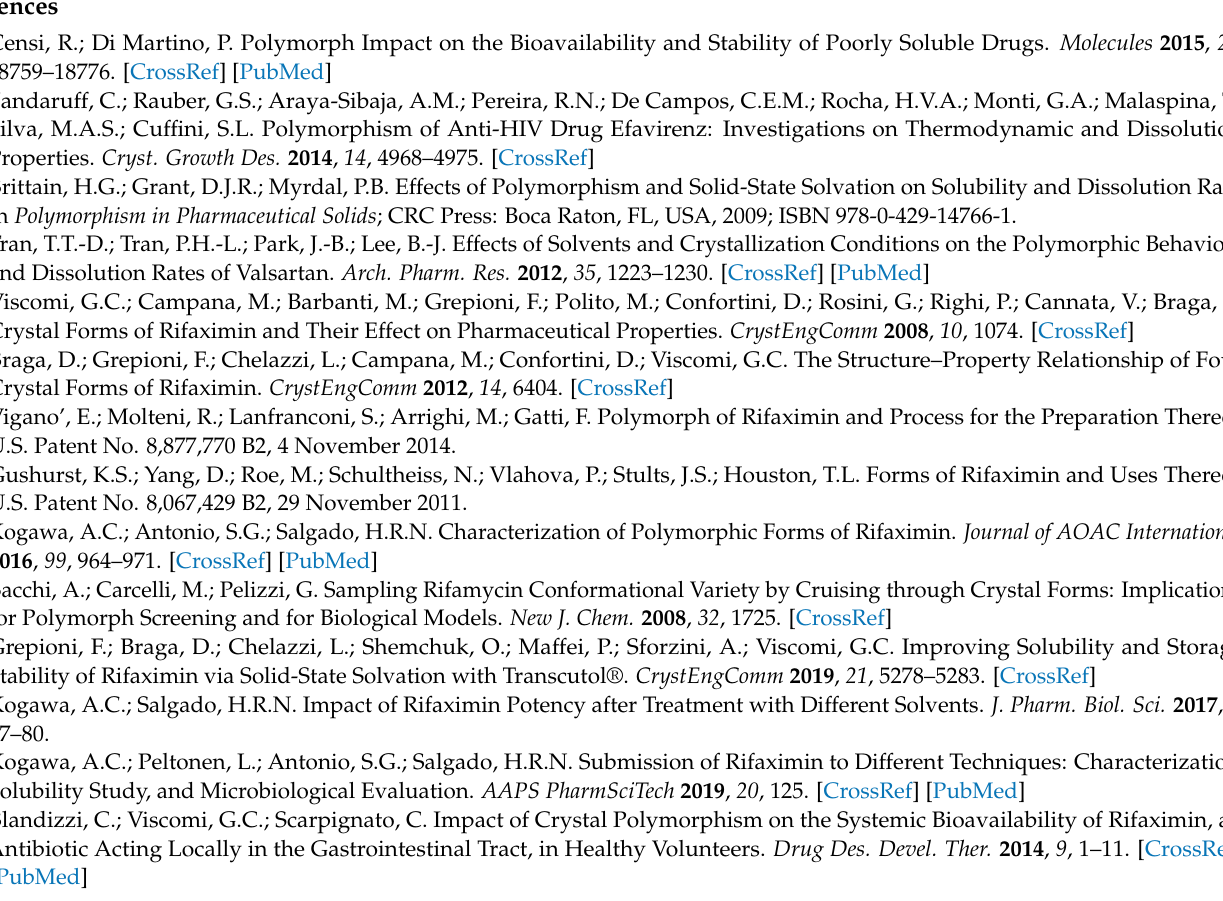
beta (Panel B), and amorphous rifaximin (Panel C); Figure S4: Experimental set up of the controlled humidity chamber. The arrow indicates the point where the samples were place on the probe window; Figure S5: PXRD of rifaximin obtained upon exposure of amorphous rifaximin to 70% RH in the DVS experiment; Figure S6: PXRD of rifaximin obtained upon exposure of α rifaximin to 50% RH (Panel A) and of the same powder recovered at 10% RH in the desorption curve (Panel B) in the DVS experiment; Table S1: Maximum concentration (C max ), time to reach the maximum concentration (T max ), area under the curve (AUC), and equilibrium concentration (EC) of the kinetic dissolution curves at 20 ◦ C of two crystalline forms and one amorphous form of rifaximin. Mean value ± standard deviation. (n =